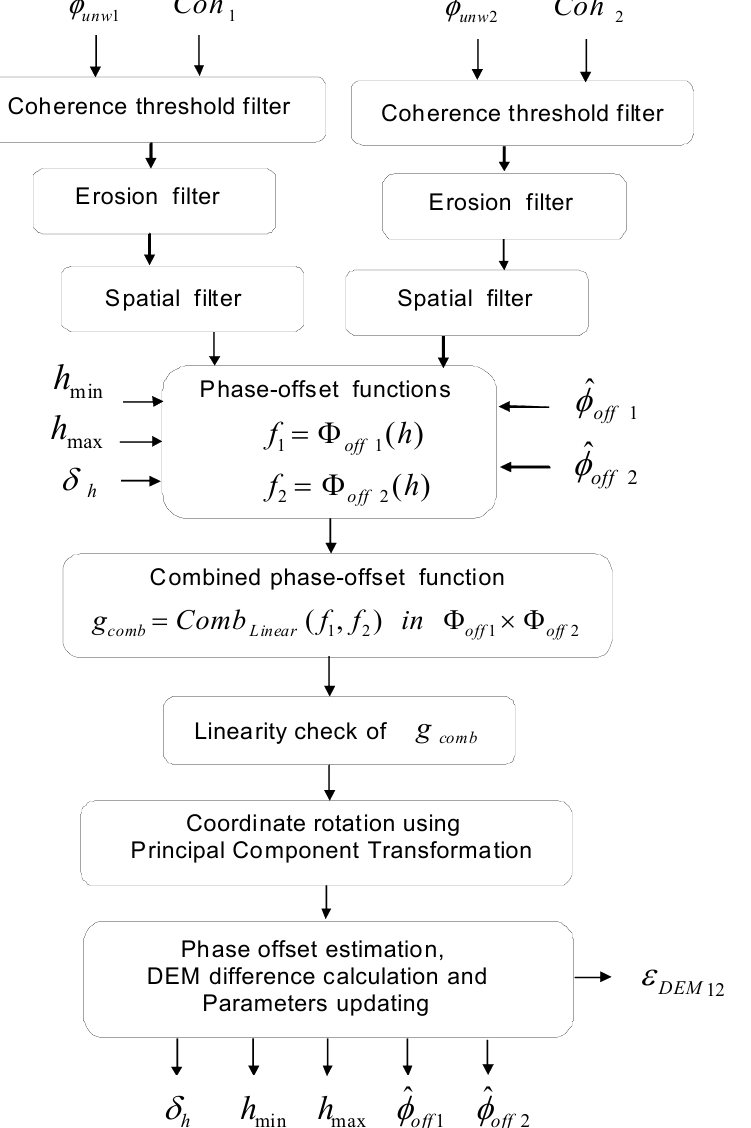
Figure 5. Processing sequence for phase-offset